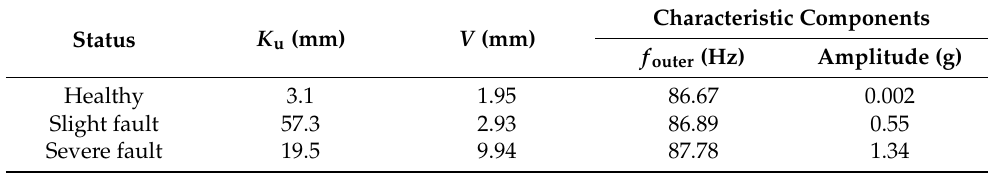
Table 6. Bearing outer race fault diagnosis results of the Y100L2-4 motor with a full load.